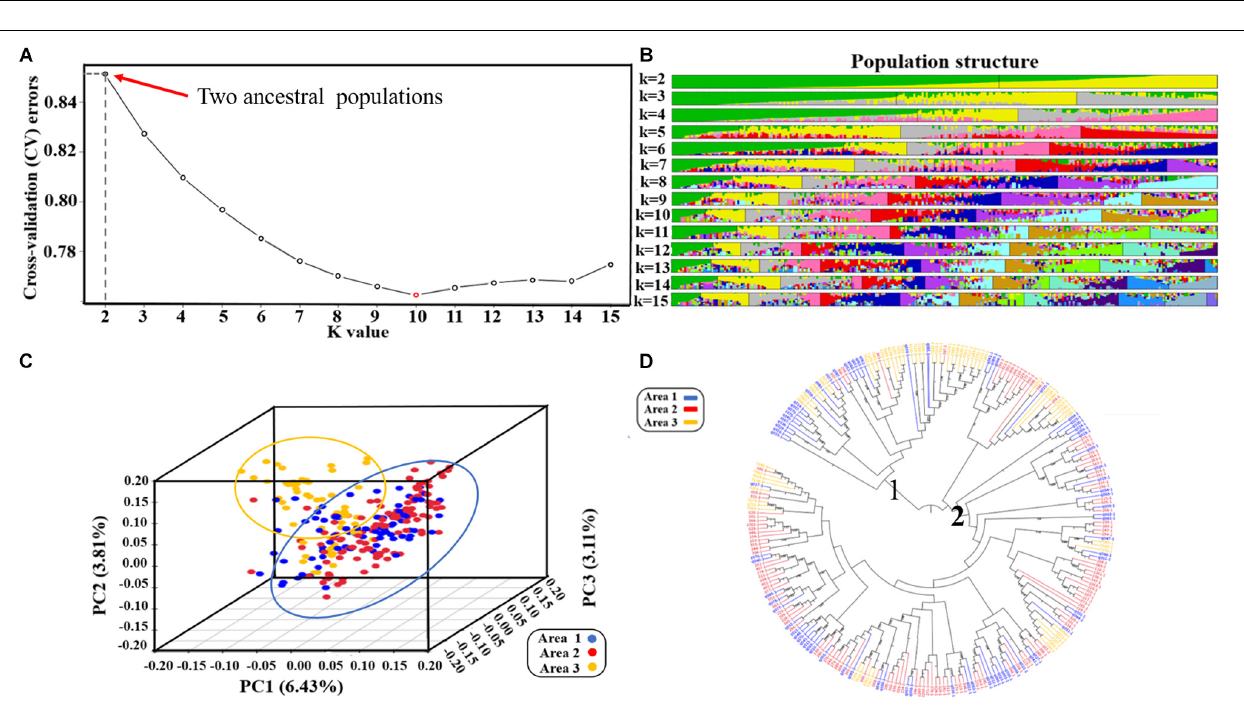
FIGURE 1 | Distribution of SNPs in 20 chromosomes of Soybean. Each color represents different densities (Liu et al., 2020).